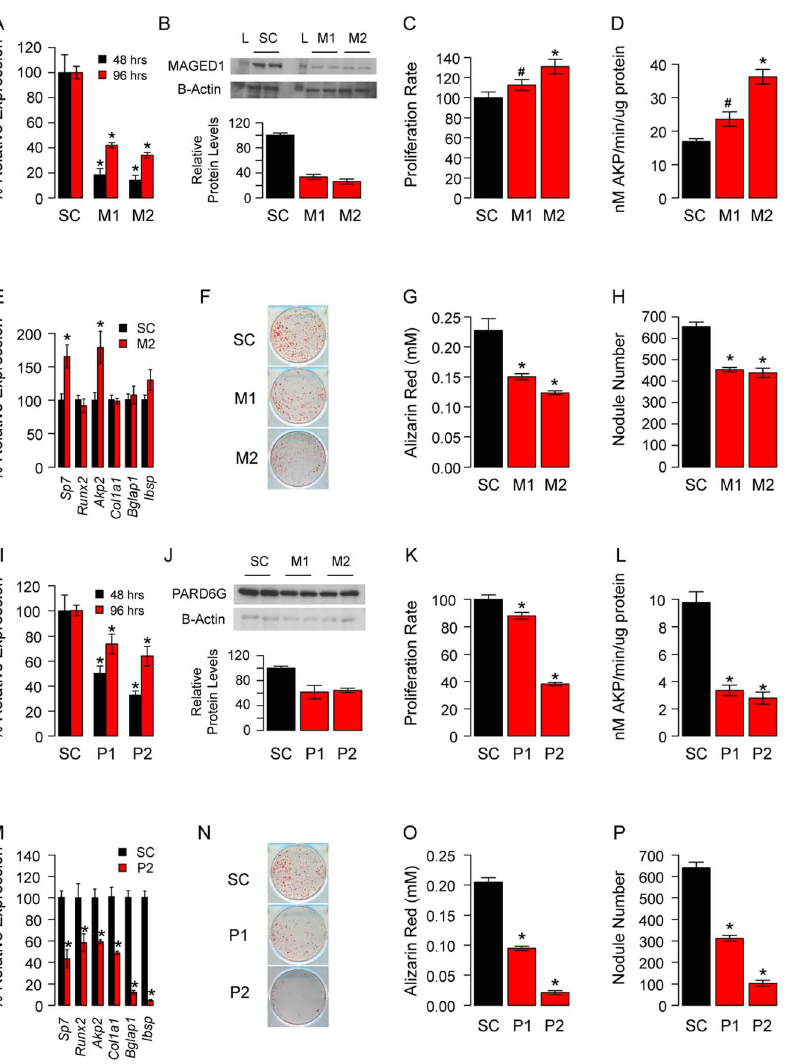
Figure 4. Maged1 and Pard6g are novel regulators of osteoblast proliferation and differentiation. (A) The siRNAs M1 and M2 significantly reduced the levels of Maged1 in undifferentiated pcOBs relative to a scrambled control (SC) at 48 and 96 hours post-differentiation. (B) This resulted in similarly decreased MAGED1 protein at 48 hours post-differentiation (L=protein ladder). (C) In undifferentiated pcOBs Maged1 knockdown increased proliferation rate. (D) After four days of osteogenic differentiation Maged1 knockdown increased alkaline phosphatase activity (E) and the expression of Sp7 and Akp2 . In contrast, at 14-days post-differentiation Maged1 knockdown significantly decreased (F) mineralized nodule formation as determined by (G) Alizarin Red staining and (H) quantification of nodule number. (I) The siRNAs P1 and P2 significantly reduced the levels of Pard6g in undifferentiated pcOBs relative to a scrambled control (SC) at 48 and 96 hours post-differentiation. (J) This resulted in similarly decreased PARD6G protein at 96 hours post-differentiation. (K) In undifferentiated pcOBs Pard6g knockdown increased proliferation rate. (L) After four days of osteogenic differentiation Pard6g knockdown decreased alkaline phosphatase activity (M) and the expression of Sp7 , Runx2 , Akp2 , Col1a1 , Bglap1 and Ibsp . (N) At 14-days after differentiation Pard6g knockdown decreased mineralized nodule formation as determined by (O) Alizarin Red staining and (P) quantification of nodule number. In all panels *P , 0.05 and # P , 0.10. The data represent mean 6 SEM (N=4–6 independent experiment, except for Westerns